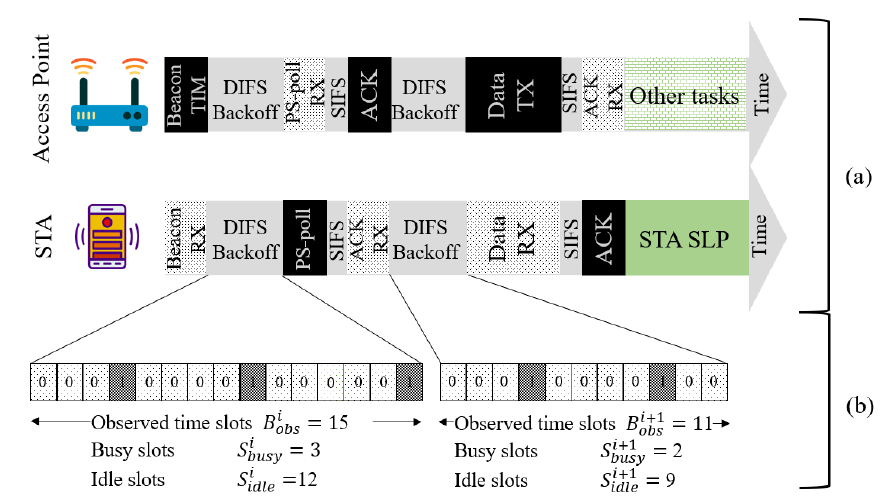
Figure 2. ( a ) Existing PSM mechanism in a WLAN. ( b ) Channel observation-based collision probability